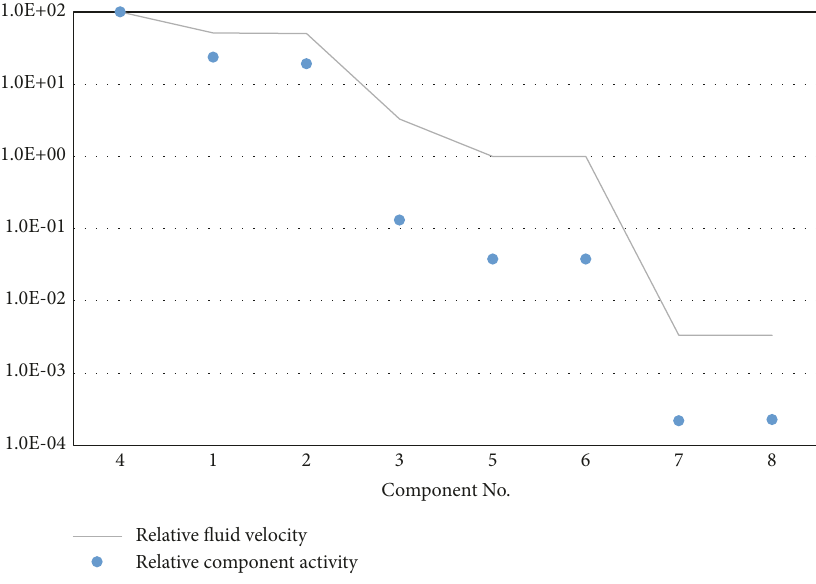
Figure 3: The interrelation between the contamination level and the coolant